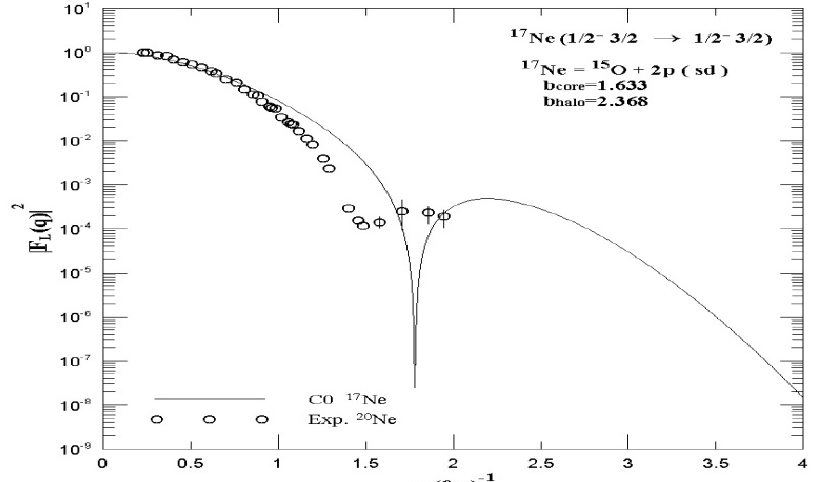
Fig. 3: The calculated elastic longitudinal C0 form factors of 17 Ne with two protons in sd-shell. the experimental data are taken from Refs